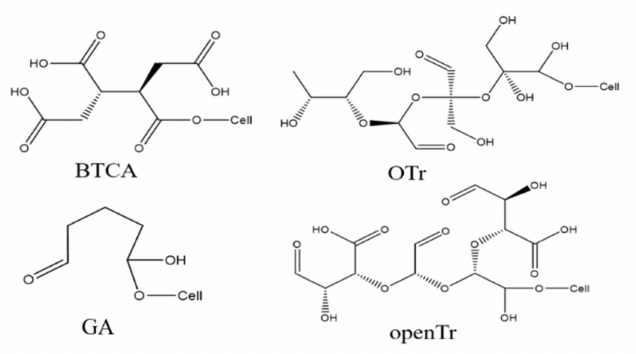
Figure 7. Single crosslinking between cellulose and crosslinker. Table 2. Energy distribution ratio under different conformations with single cross-linked. Molecular